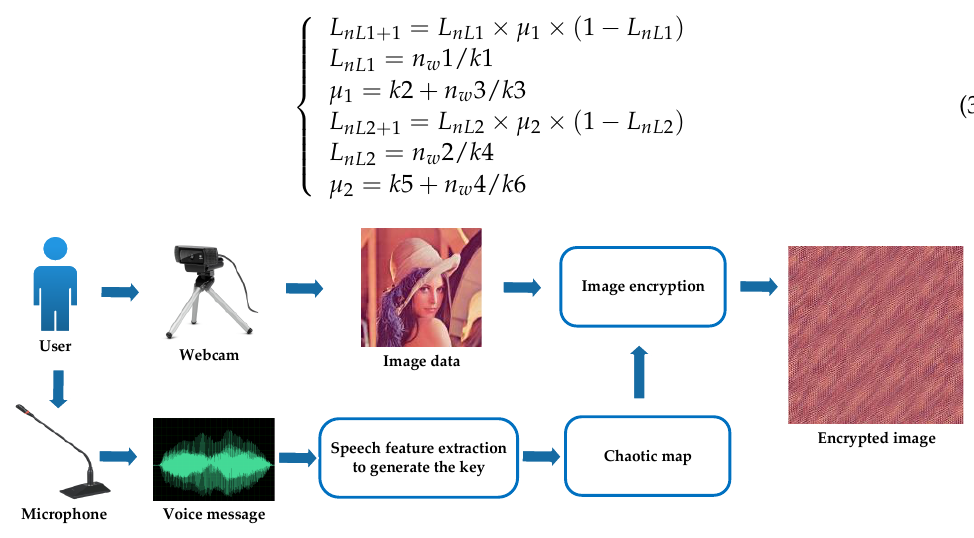
Figure 2. Encryption process.